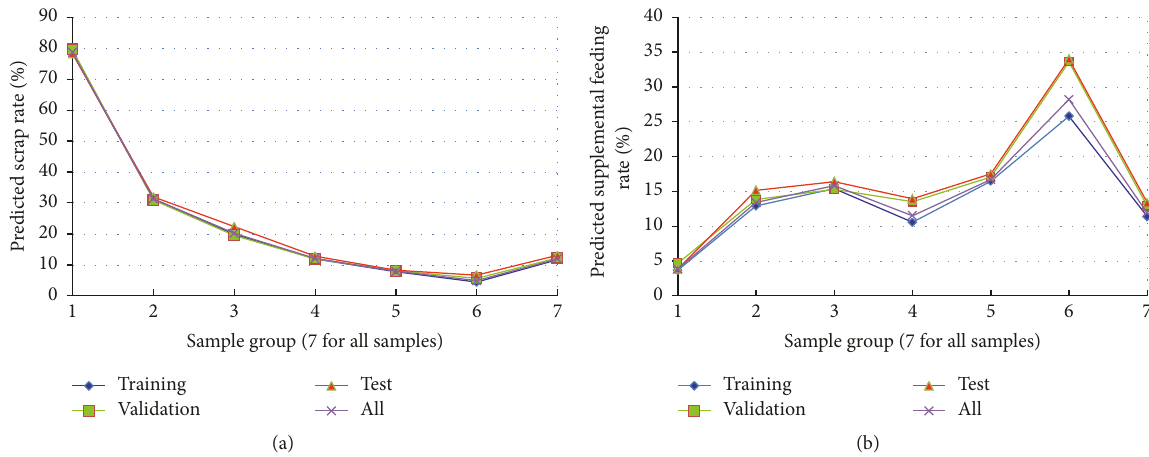
Figure 9: (a) Predicted scrap rate of MSCM-ANN for different samples. (b) Predicted supplemental feeding rate for different samples.